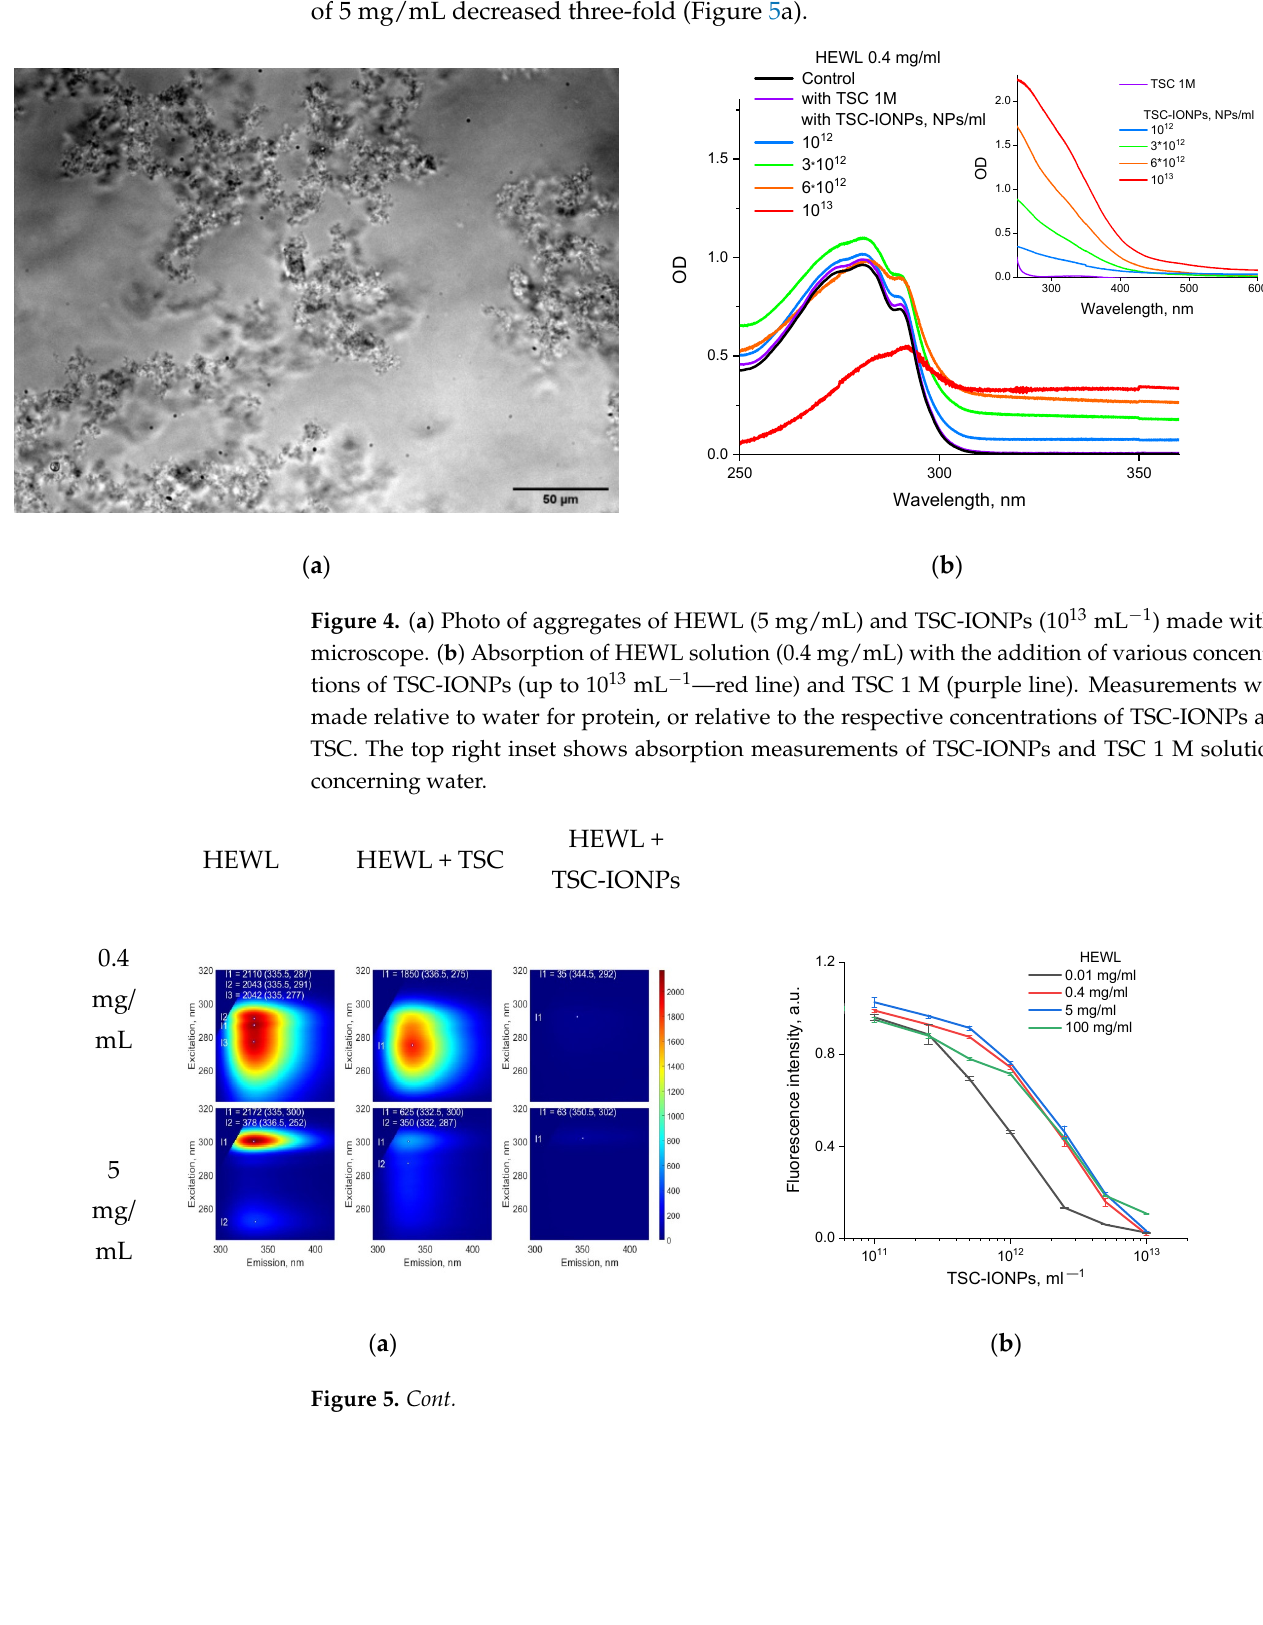
( b ) Figure 3. ( a ) EDS analysis of distribution of carbon (left top), oxygen (left bottom), iron (right top) in the sample (right bottom) TSC-IONPs (10 13 mL − 1 ) with HEWL (5 mg/mL); ( b ) energy dispersive spectroscopy results for TSC-IONPs with HEWL.